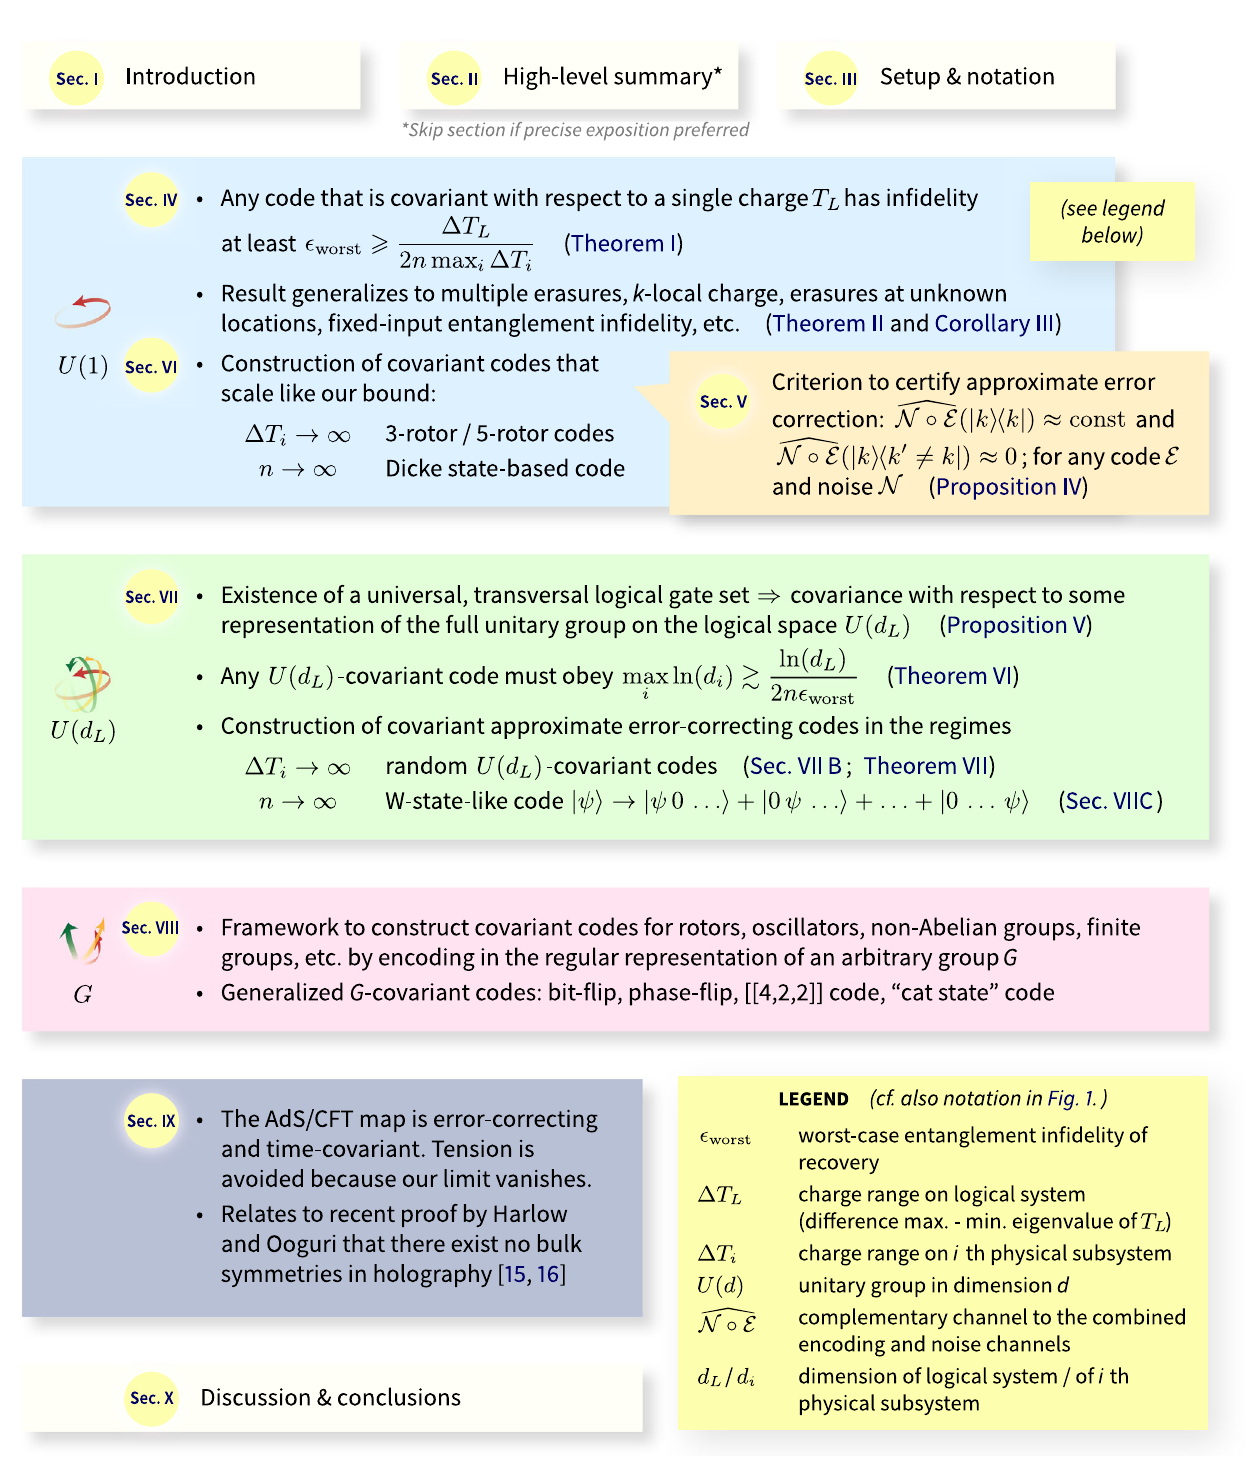
FIG. 2. Overview of our main results and structure of the